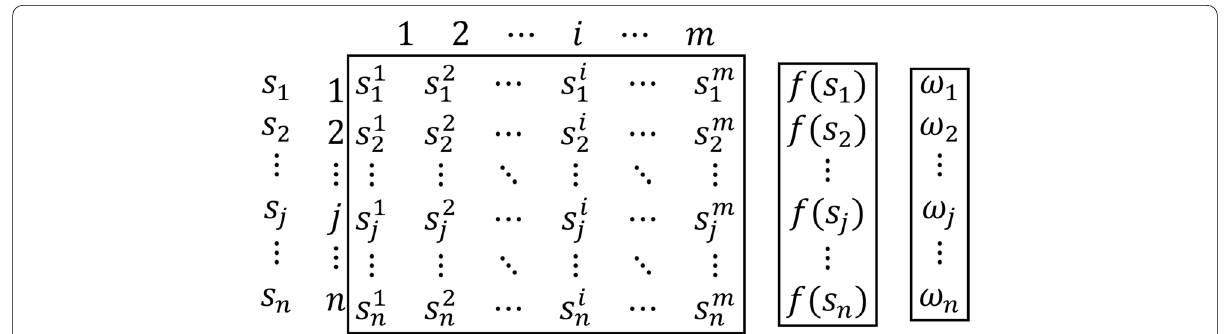
Fig. 2 The structure of solution